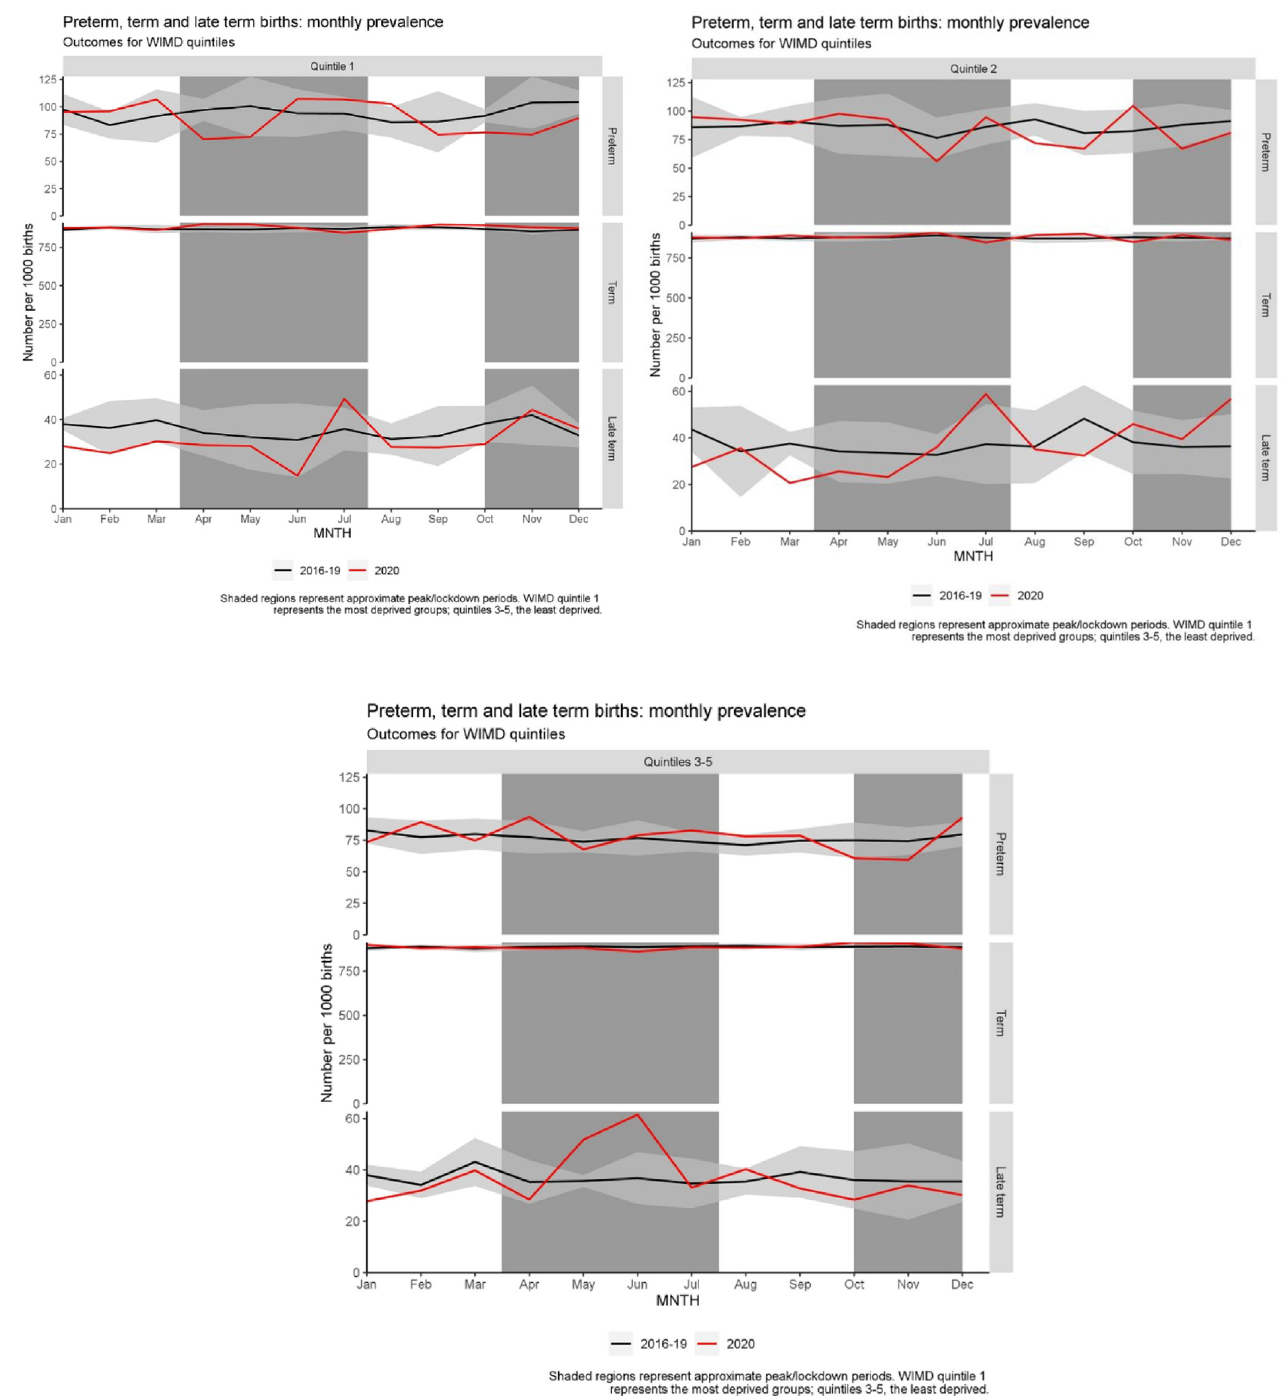
Fig 2. Birth outcomes by month, stratified by deprivation. Monthly prevalence of births categorised preterm (32–36 weeks gestation), term (37–41 weeks) and late-term ( � 42 weeks) per 1000 births. Each represents the Welsh Index of Multiple Deprivation (WIMD) quintile to which each birth belongs. Quintile 1 represents the most deprived groups, whereas quintiles 3–5 represent the least deprived quintiles. The shaded areas in each represent approximate times during which Wales was subject to pandemic restrictions and lockdown. Black lines represent the mean number per 1000 births between 2016–2019, inclusive.